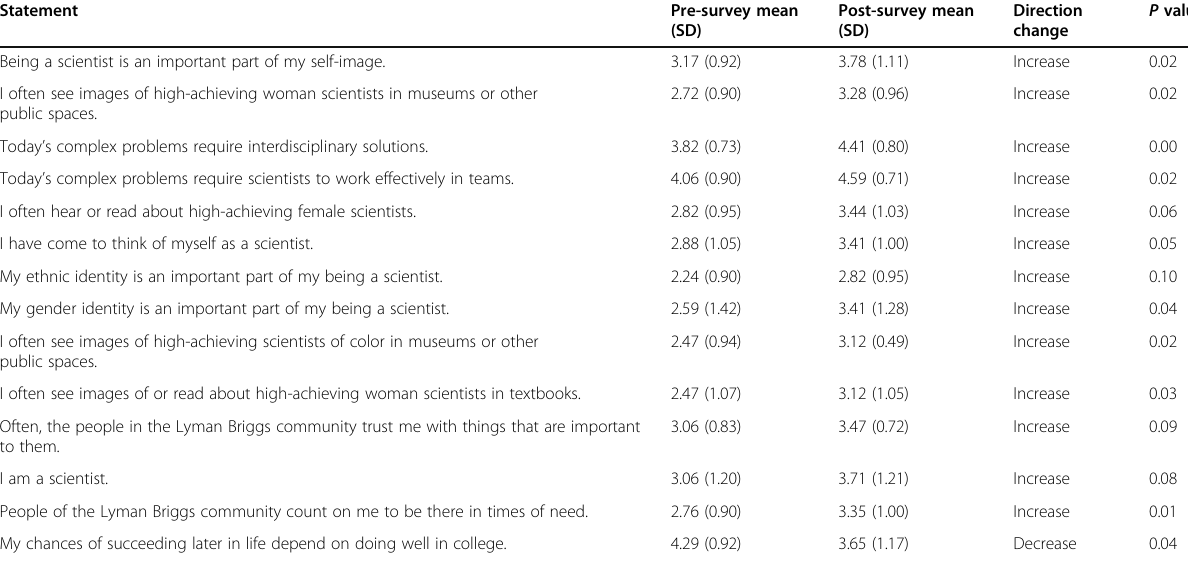
Table 2 Mean agreement with the survey statement for the treatment